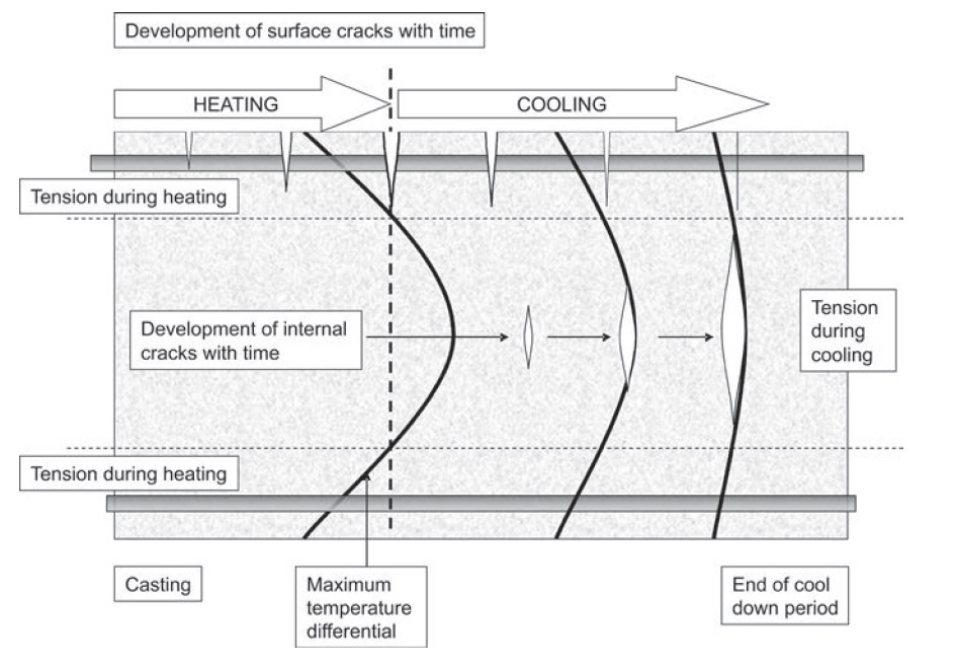
Figure 1: Thermal cracking development in time (Bamforth, 2007,